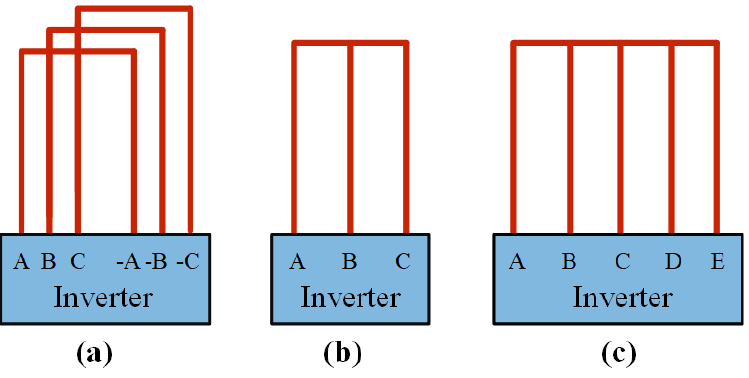
Figure 1. Winding distribution with ( a ) conventional distributed winding. ( b ) Three phase turnless structure. ( c ) Five-phase single-turn structure.